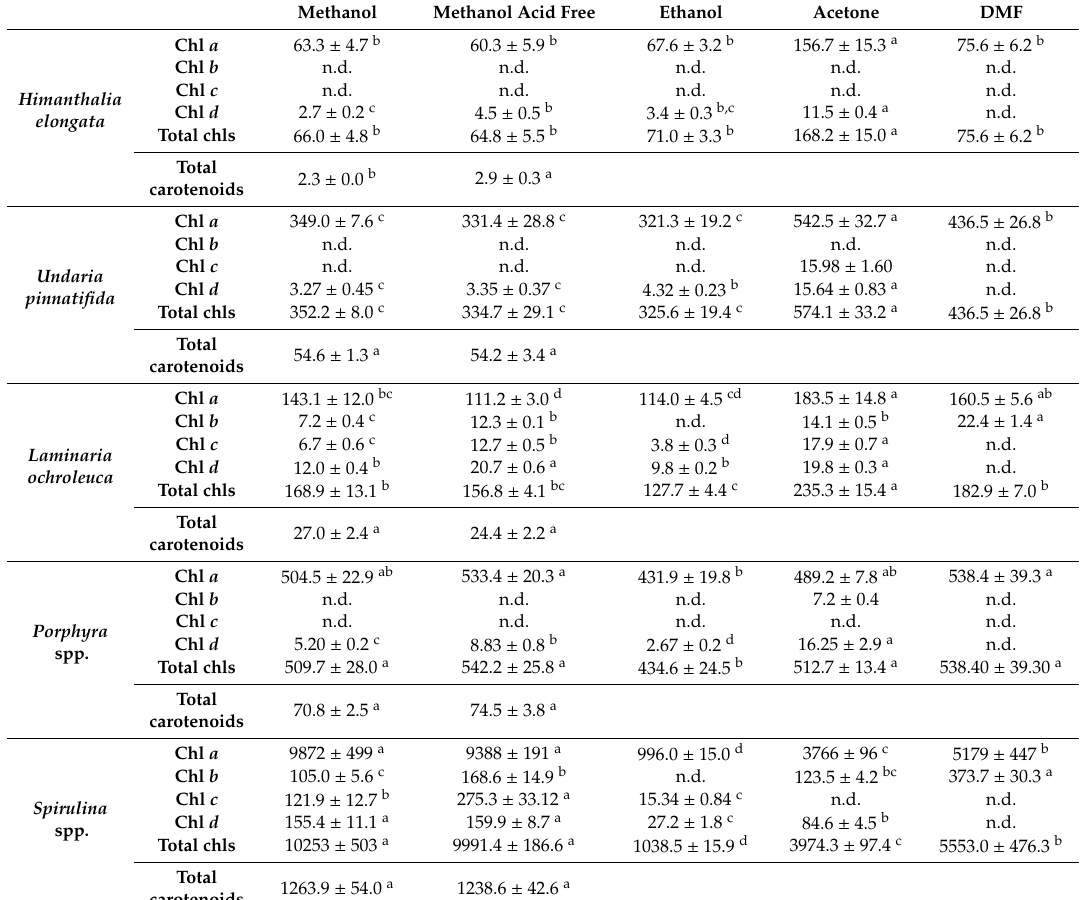
Table 1. Content of chlorophylls and carotenoids extracted from three brown edible algae ( Himanthalia elongata , Laminaria ochroleuca (Kombu), Undaria pinnatifida (Wakame)), a red one ( Porphyra spp. (Nori)), and microalgae ( Spirulina spp.) using di ff erent solvents. The results are expressed in µ g / g of algae. Methanol Methanol Acid Free Ethanol